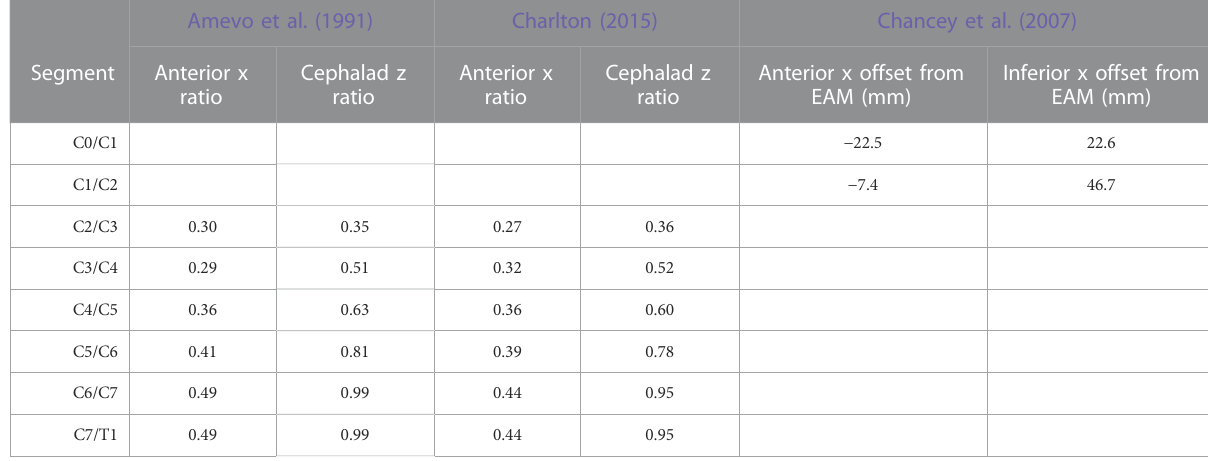
TABLE 2 The absolute reported values of upper cervical spine ICR locations with respect to the EAM (mm) and normalised lower cervical spine ICR location ratios with respect to the inferior vertebral body dimensions. Amevo et al. (1991) Charlton